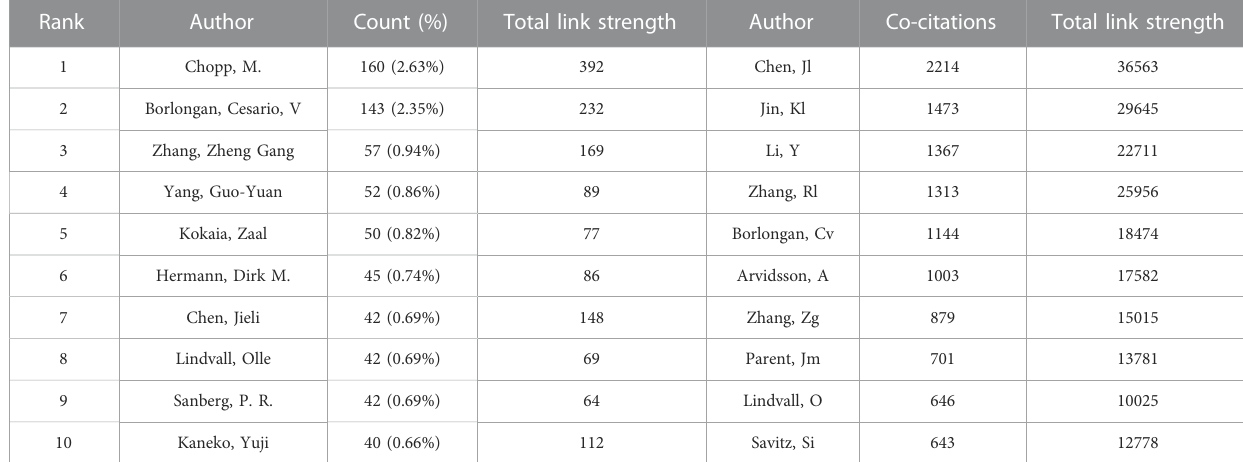
TABLE 3 Top 10 authors and co-cited authors related to stem cells in